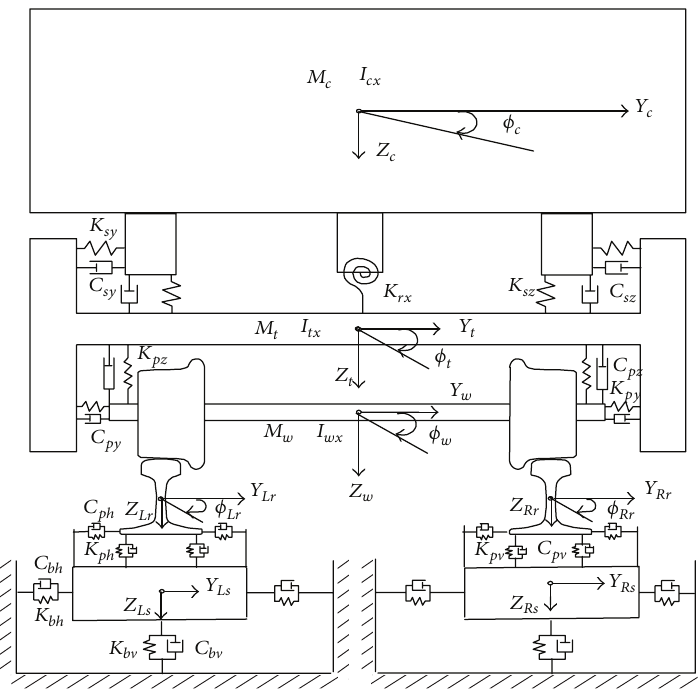
Figure 3: Side view of the dynamic